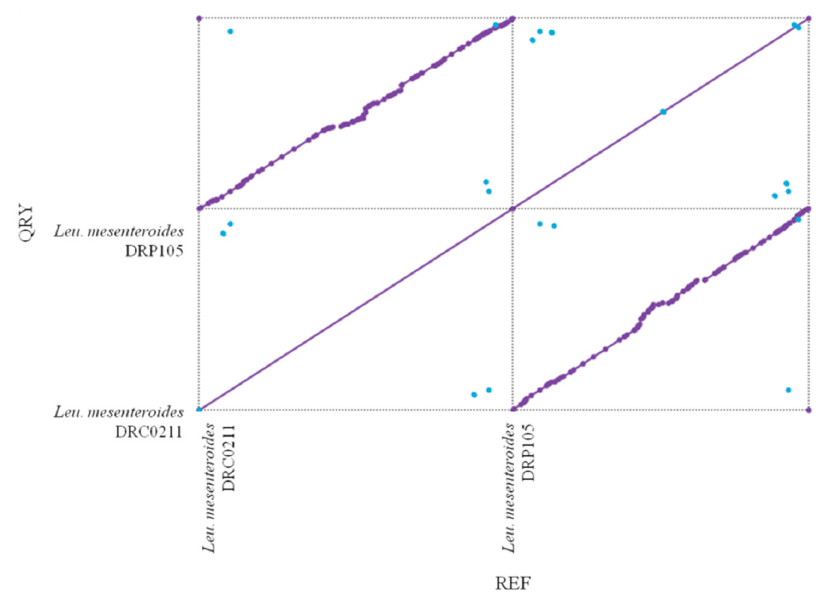
Figure 5. Collinearity analysis of Leu. mesenteroides DRP105 and Leu. mesenteroides DRC0211.